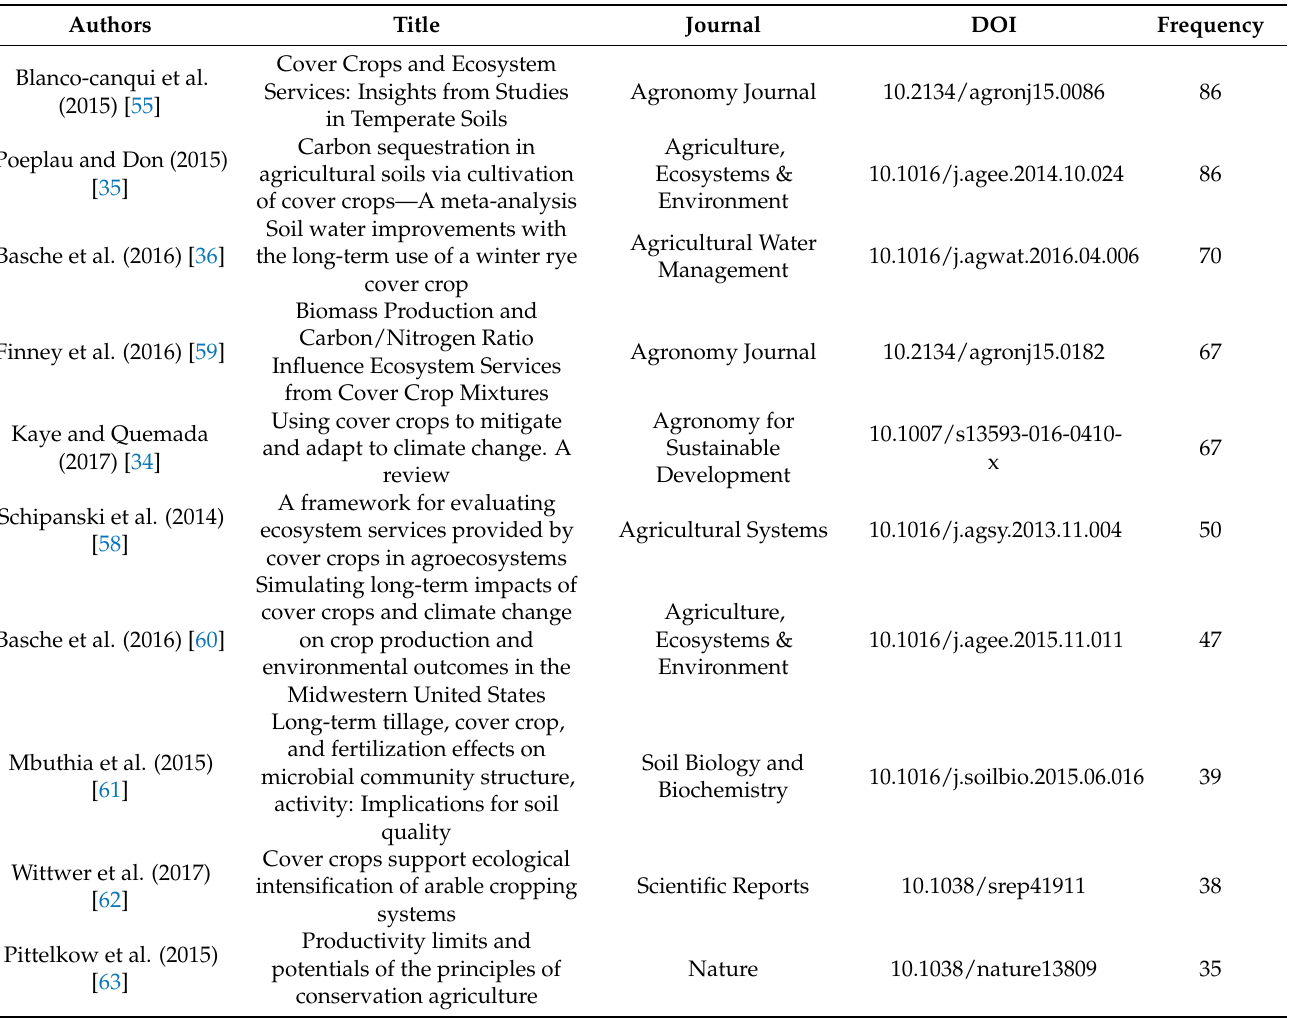
Table 4. Top ten articles based on co-citation